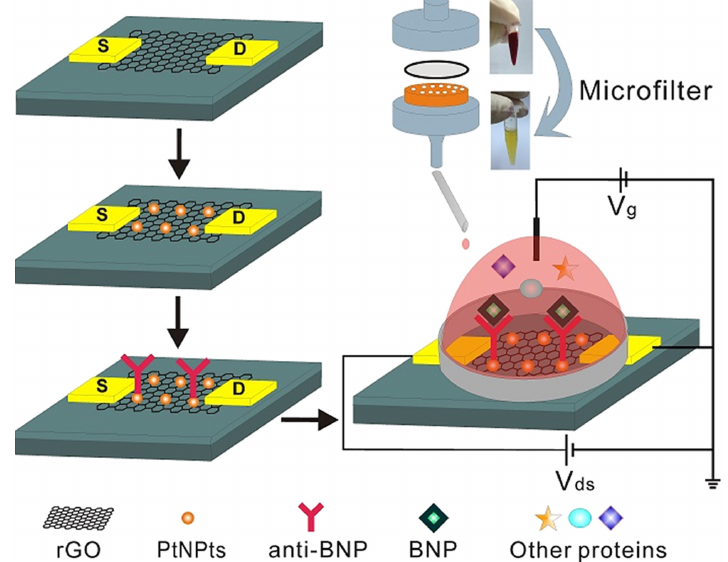
Figure 4. Schematic of a BNP immunoassay on a rGO FET decorated with PtNPsfor signal amplification. The biosensor employs a custom-made microfilter and polycarbonate membranes to allow measurement in whole blood by removing blood cells